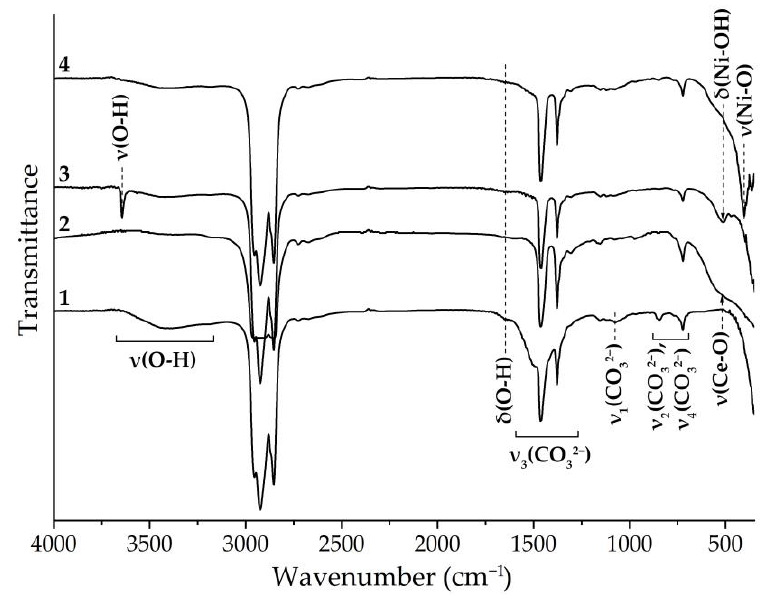
Figure 3. IR spectra of the M(OH)CO 3 (M = Ce 4+ ; Sm 3+ ) ( 1 ), (CeO 2 ) 0.8 (Sm 2 O 3 ) 0.2 ( 2 ), ((CeO 2 ) 0.8 (Sm 2 O 3 ) 0.2 )@β -Ni(OH) 2 ( 3 ), and ((CeO 2 ) 0.8 (Sm 2 O 3 ) 0.2 )@NiO ( 4 ) powders after drying ( 1 and 3 ) and additional heat treatment ( 2 and 4 ).